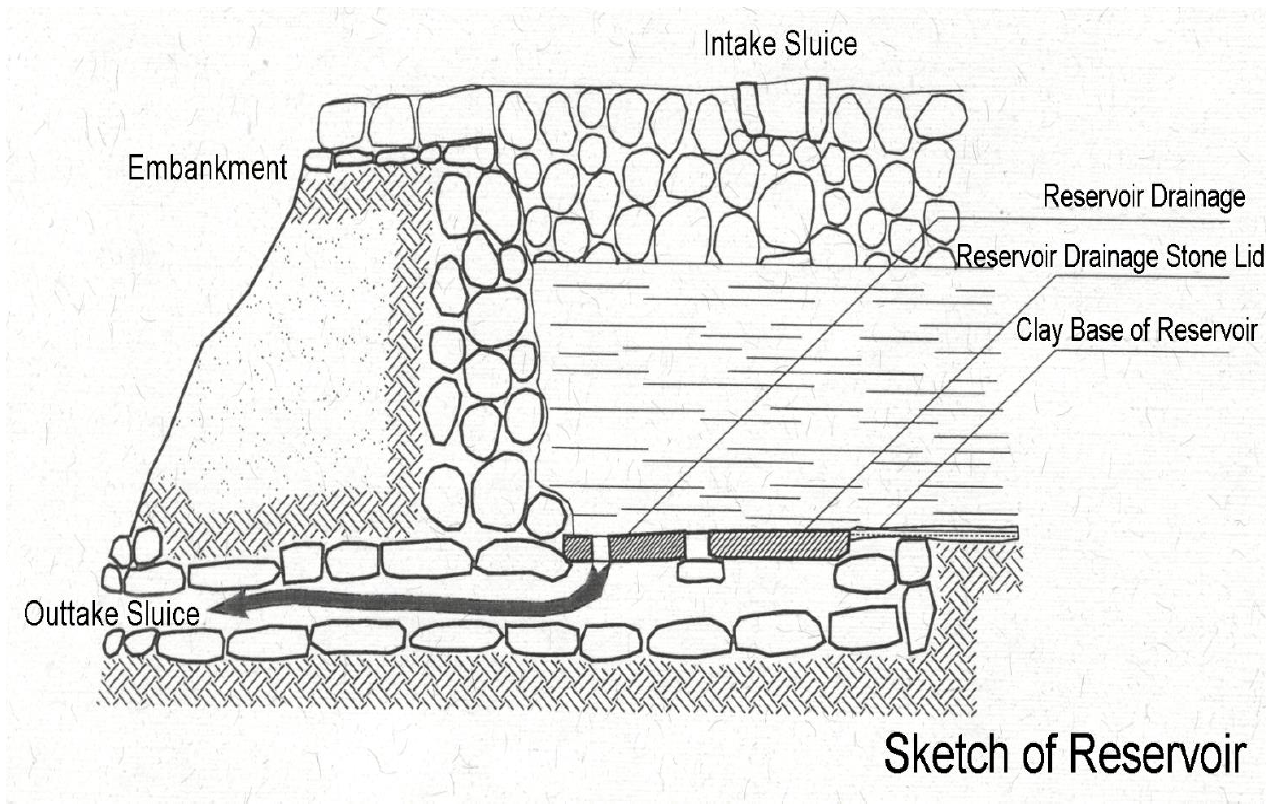
Figure 12. Sketch of the internal plan of a reservoir adapted from [91].